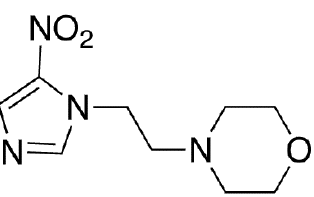
Figure 1. Chemical structure of nimorazole (NIMO), C 9 H 14 N 4 O 3 .